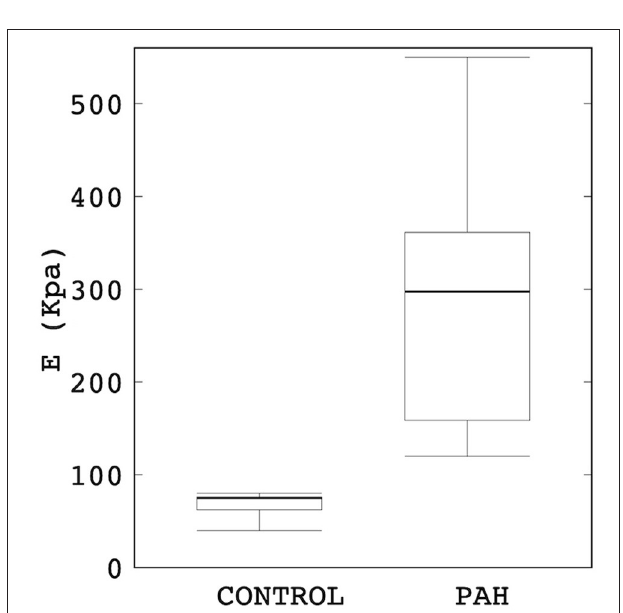
FIGURE 2 | Comparison of the estimated linearized stiffness E between PAH and control groups (median: 297 kPa, IQR: 202 kPa vs. median: 75 kPa, IQR: 5 kPa; P 0.007). The PAH group’s E is approximately four times higher than = the control group.